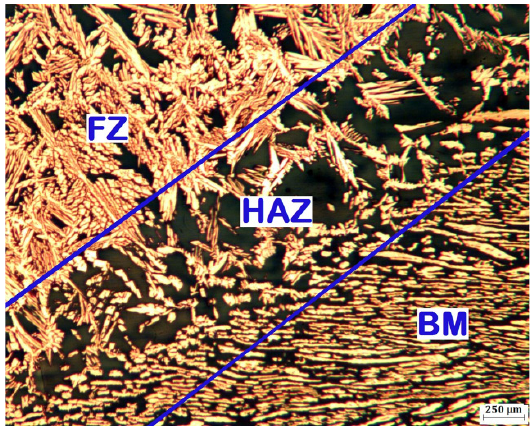
Figure 8. a) Local heating and b) cooling rates ( o C s –1 ) achieved in a same section of the plate during welding (0.6 kJ mm –1